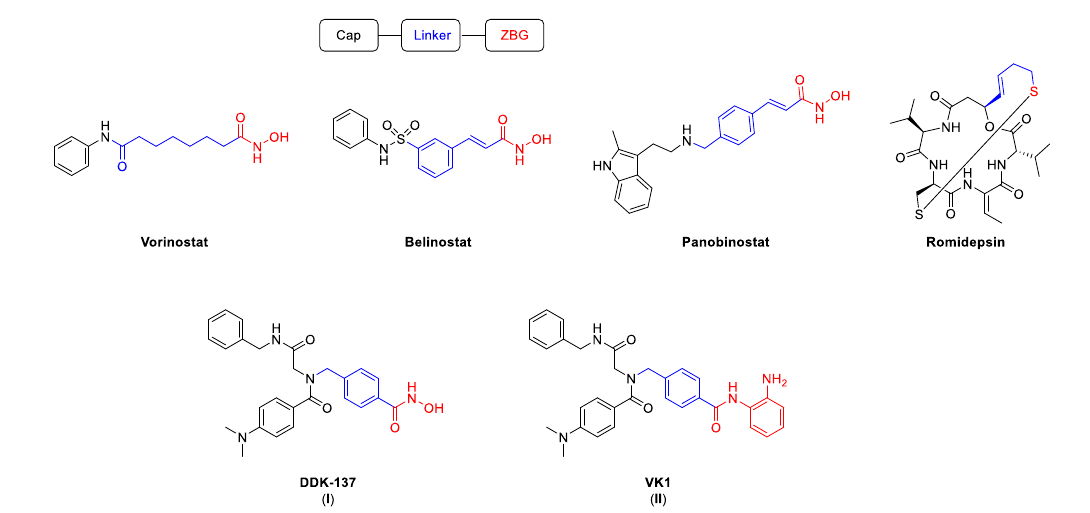
Figure 1. Selected HDACi, including the established HDAC pharmacophore model. Cap, linker, and ZBG are highlighted in black, blue, and red, respectively. ( A ) Structures of FDA-approved HDACi. ( B ) Structures of the peptoid-based HDACi DDK-137 ( I ) and VK1 ( II ) [7,8].